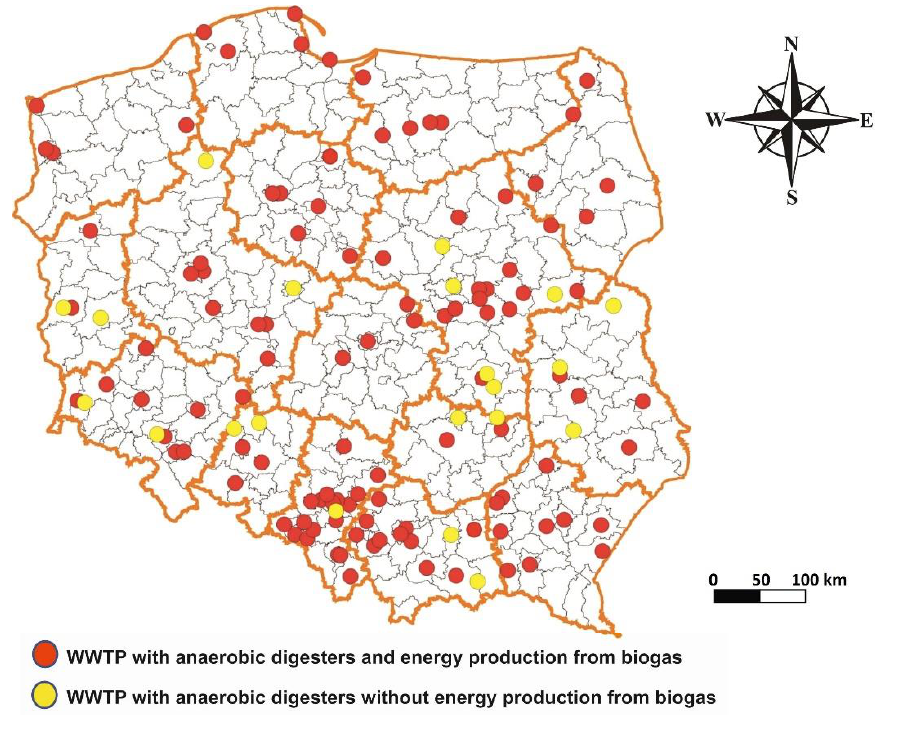
Figure 3. WWTPs in Poland utilizing the anaerobic digestion of sewage sludge, data from [69].